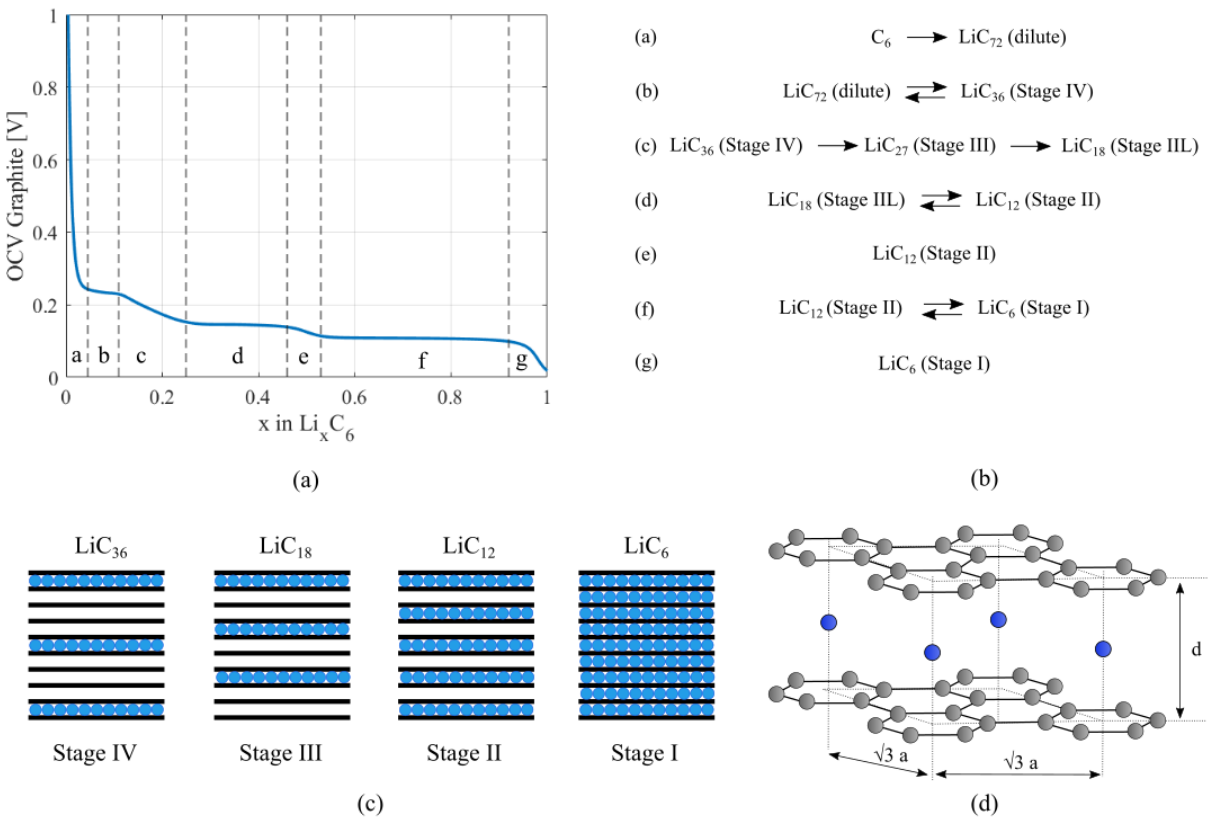
Figure 1. OCV of graphite ( a ) and description of phase transitions ( b ). L stays for dilute, which means that ions are distributed in a liquid way within the layers, and not methodically ordered. Configuration of lithium ions (blue circles) inside carbon layers (black lines) for each stage ( c ). Crystal structure of graphite with stacking configuration of phase I and II correlated with its lattice parameters ( d ): blue spheres are intercalated lithium ions, grey spheres are carbon